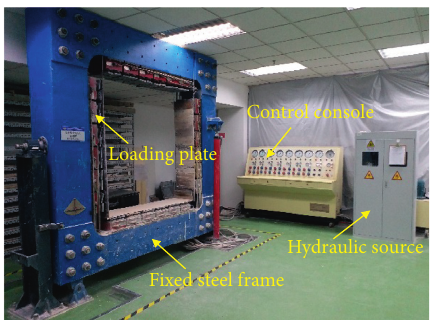
Figure 3: Physical model testing